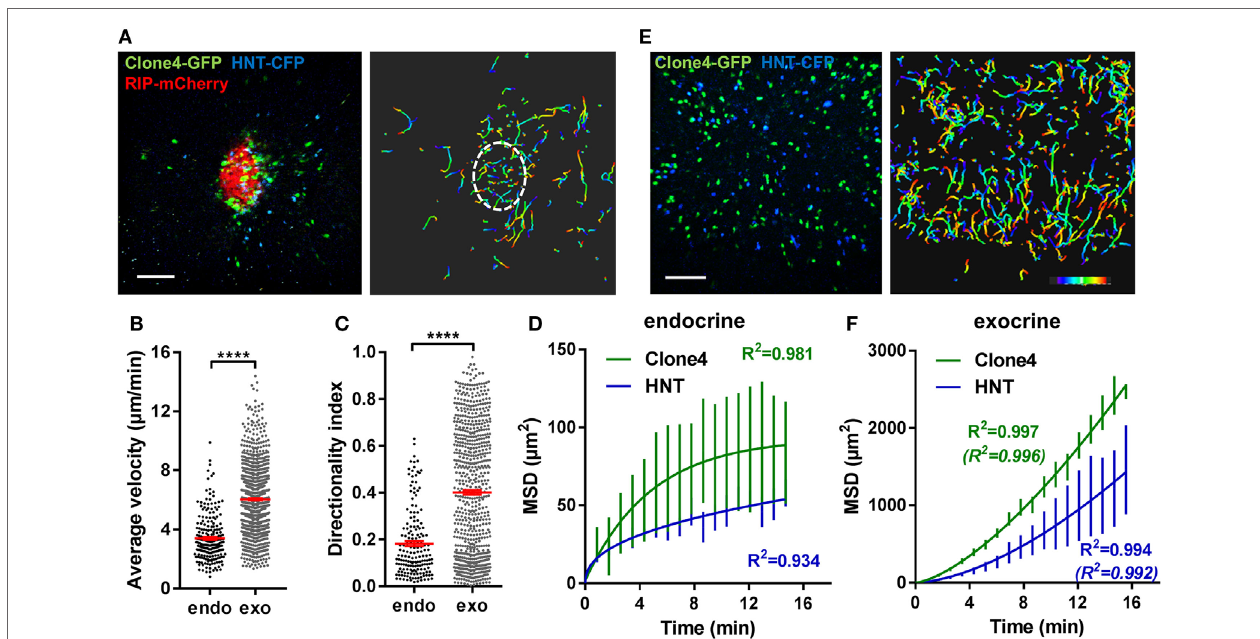
FigUre 1 | Motility of islet-antigen-specific CD8 + and CD4 + T lymphocytes in vivo . Irradiated InsHA-mCherry mice adoptively transferred with Clone 4-GFP CD8 + and HNT-CFP CD4 + T cells were subjected to intra-vital microscopy on day 8. (a) Still image from a representative movie (left panel; scale: 100- and 200-µm Z -projection; red: mCherry, green: GFP, blue: CFP) (see Video S1 in Supplementary Material) and the corresponding T cell tracks (right panel), color-coded as a function of time. Islet is circled. Movie duration: 15 min. (B) Average velocities of pooled CD4 + and CD8 + T cells in exocrine and endocrine tissues ( n = 4 mice/ condition; 1–2 movies/mouse, Mann–Whitney). Dots correspond to individual T cells. (c) Directionality indexes (ratio between displacement and total track length) of T cells in exocrine and endocrine tissues ( n = 4 mice/condition; 1–2 movies/mouse, Mann–Whitney). Dots correspond to individual T cells. (D) Mean squared displacement (MSD) of T cells as a function of time in islets, best fitted with a confined model of migration for Clone4-GFP cells and with sub-diffusive random walk for HNT-CFP cells. Bars correspond to SEM ( n = 4 mice/condition; 1–2 movies/mouse). (e) Still image from a representative movie in the exocrine tissue (left panel; scale: 100- and 200-µm Z -projection; green: GFP, blue: CFP) (see Video S2 in Supplementary Material) and the corresponding T cell tracks (right panel), color- coded as a function of time. Movie duration: 19 min. (F) MSD of T cells as a function of time in the exocrine tissue, best fitted with a Lévy walk model of migration. Between brackets are R 2 -values of fit for ballistic (directed) motility. Bars correspond to SEM ( n = 4 mice/condition; 1–2